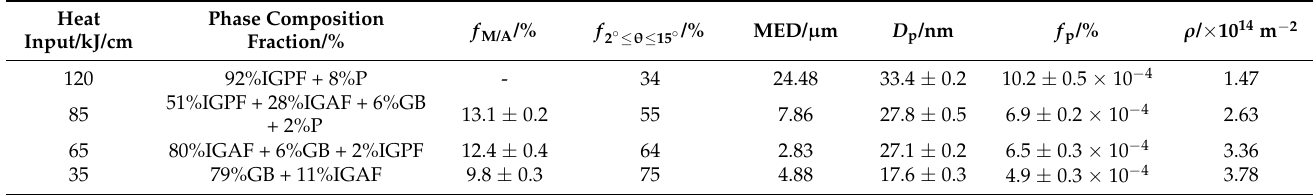
Table 2. Summary of the microstructure examinations and quantification.